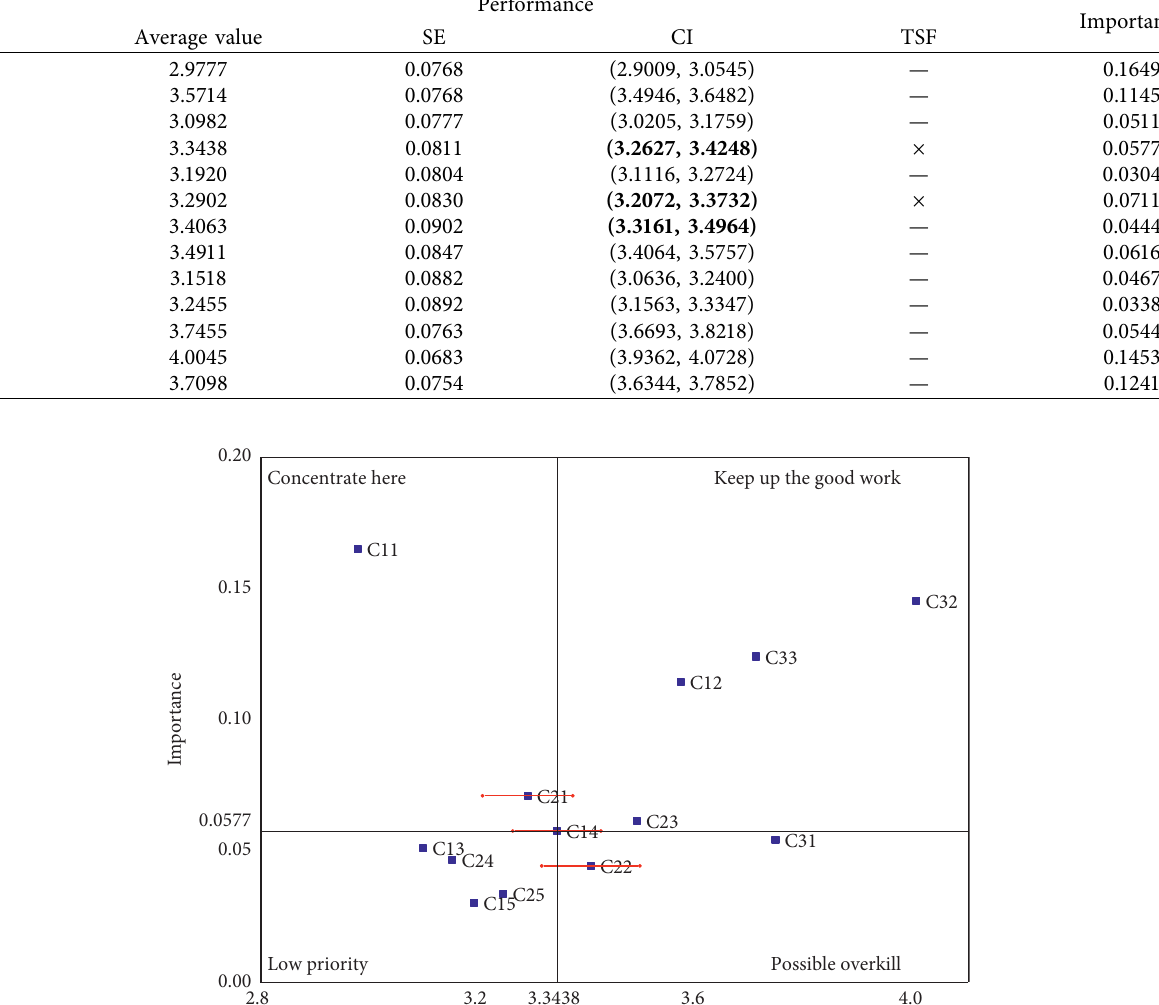
Table 5: Importance-performance analysis results.